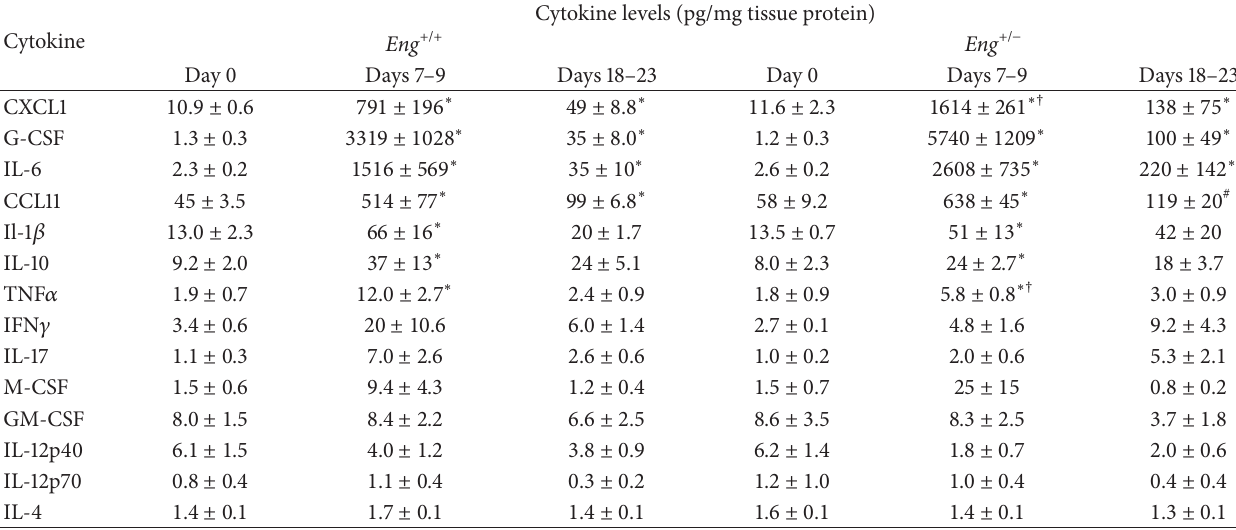
Results represent mean ± SEM (for both genotypes, 𝑁 = 4 mice for day 0, N = 7-8 mice for days 7–9 and 18–23). ∗ 𝑃 < 0.05 versus corresponding day 0, # 𝑃 = 0.06 versus corresponding day 0, and † 𝑃 < 0.05 versus corresponding Eng +/+